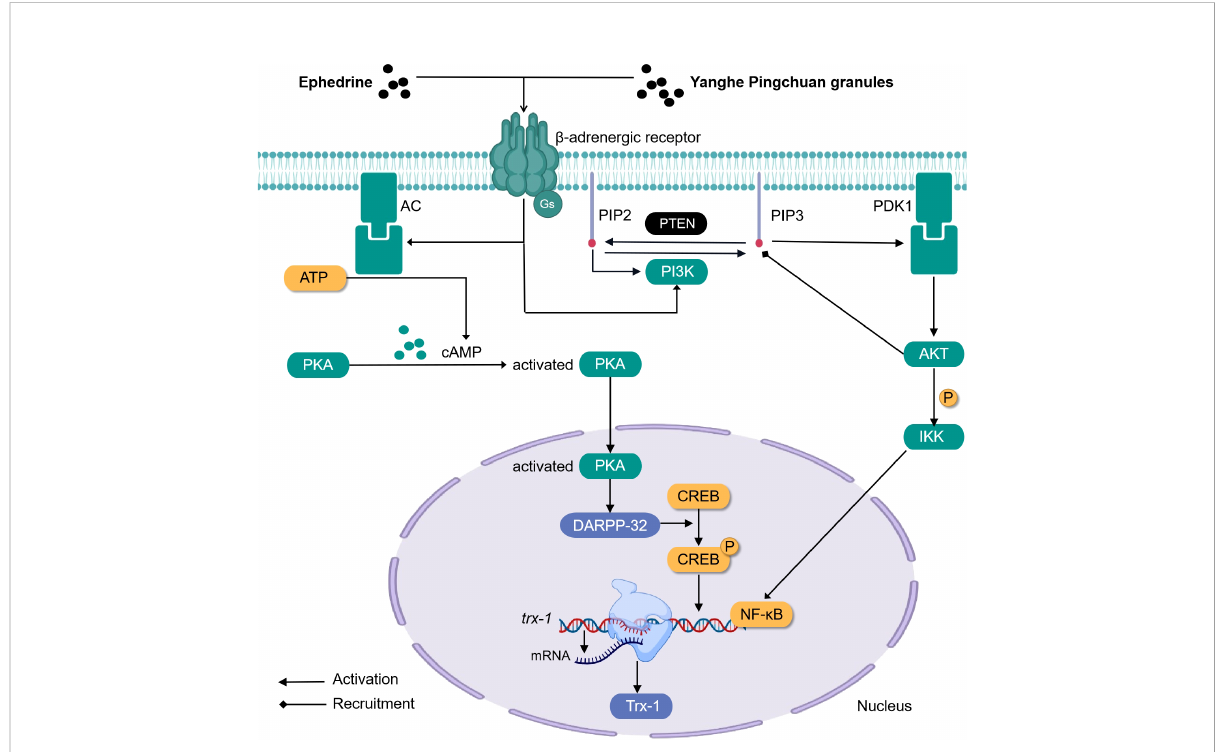
FIGURE 4 Simpli fi ed schematic diagram of cellular endocrine mechanism of some traditional Chinese medicine monomers and prescriptions for the treatment of